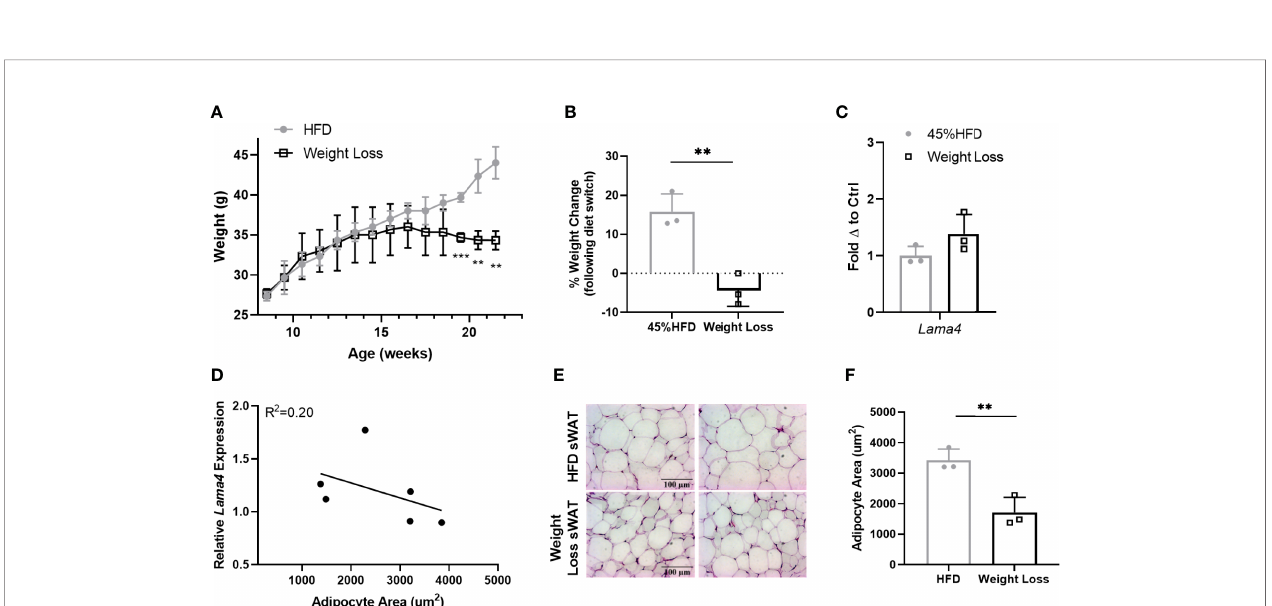
FIGURE 6 | LAMA4 expression does not change following HFD feeding reversal in mice. (A) Average weekly weights of mice on 45% HFD for 14 weeks (HFD) or 45% HFD for 8 weeks and then RCD for 6 weeks. HFD (n=3), Weight Loss (n=3), (**,***) indicates p < 0.01, 0.001, respectively. (B) Weight change shown as percentage from timepoint of diet switch (16 weeks of age) until end of dietary study (22 weeks of age). Data are Means ± SD. (C) Lama4 mRNA expression in sWAT of mice in HFD (n=3) or Weight Loss (n=3) group. (D) Relative Lama4 mRNA expression graphed against adipocyte area (um 2 ) (n=6). Simple linear regression analysis. (E) Representative images of H&E stained sWAT tissue sections of HFD and Weight Loss group mice after 14 weeks of dietary study. All images are 40X magni fi cation. (F) Adipocyte area (um 2 ) in sWAT of mice in HFD (n=3) and Weight Loss (n=3)